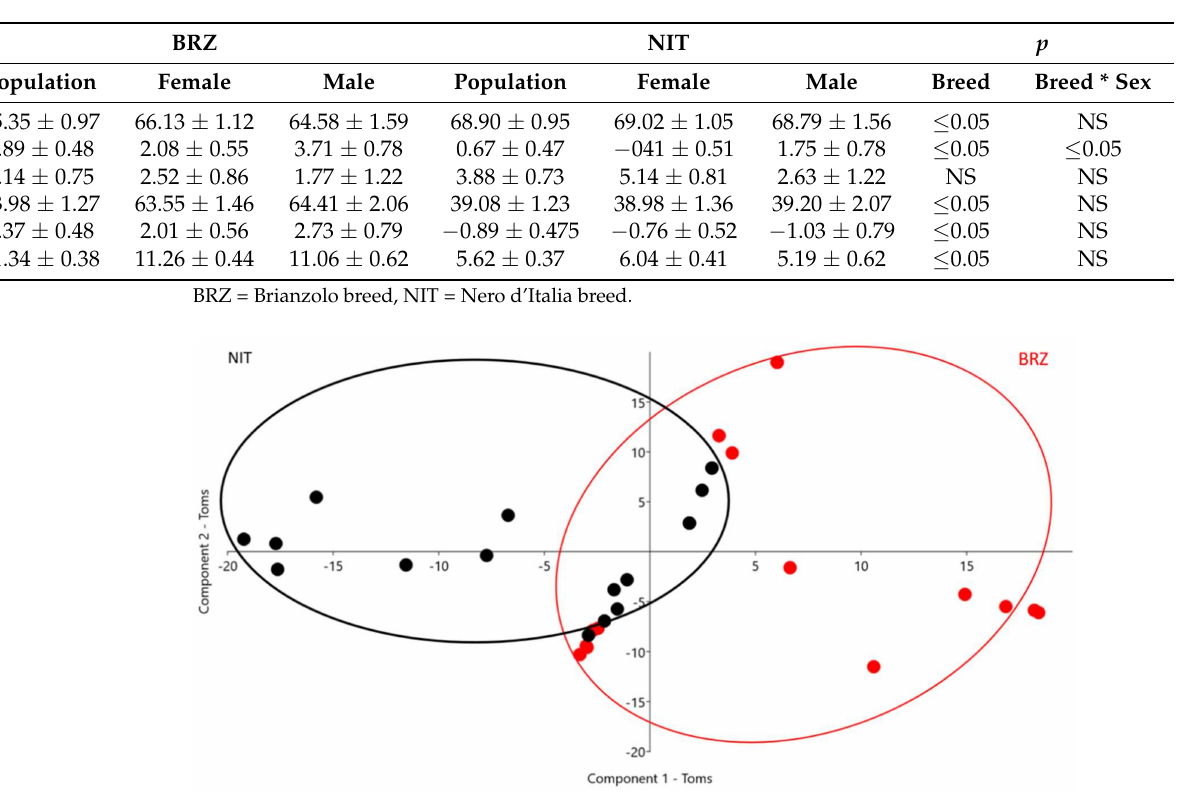
Table 3. Colorimetric indexes: L* lightness (L), a* yellowness (A), b* redness (B): body skin (SK), and shank (SH). SKL: skin lightness; SKA: skin yellowness; SKB: skin redness; SHL: shank lightness; SHA: shank yellowness; SHB: shank redness by breed and breed per sex interaction. Least-square means ± standard error.